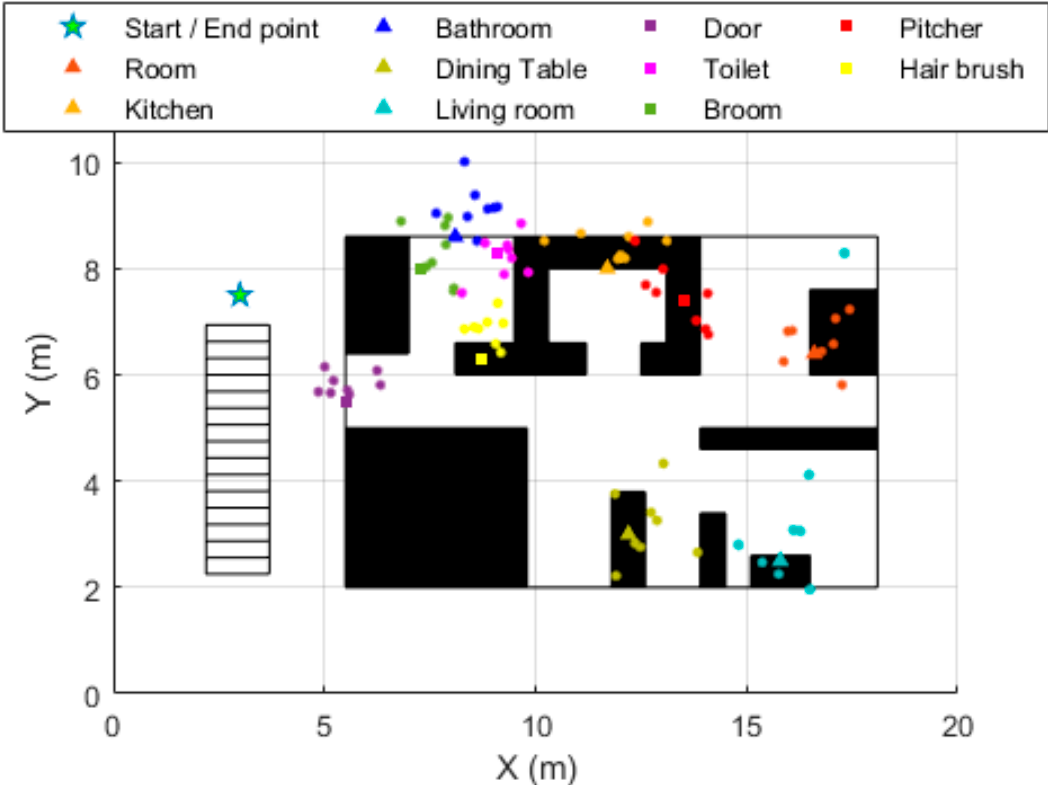
Figure 6. Graphic results of the beacons localization. Points are the beacons’ locations estimates. Each point corresponds to the average of the 10 location estimates of a beacon for each participant. The ground-truth location and the location estimates for each beacon share the same color. Table 5. Average localization error for each participant (ten runs).